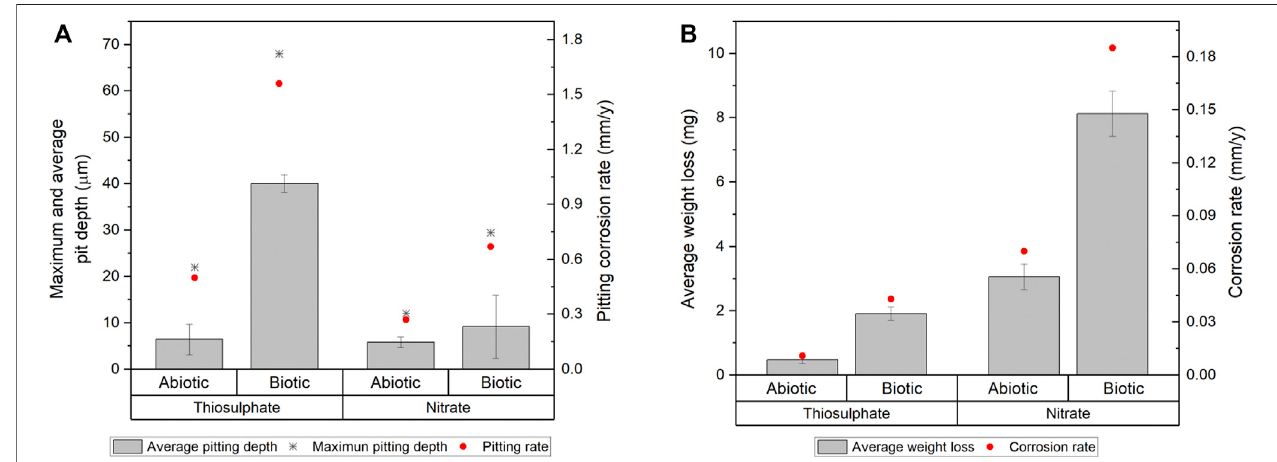
FIGURE6| Localisedcorrosion (A) anduniformcorrosionmeasurements (B) ofcarbonsteelcouponsafter16-daysimmersiontothiosulphateandnitratereducing